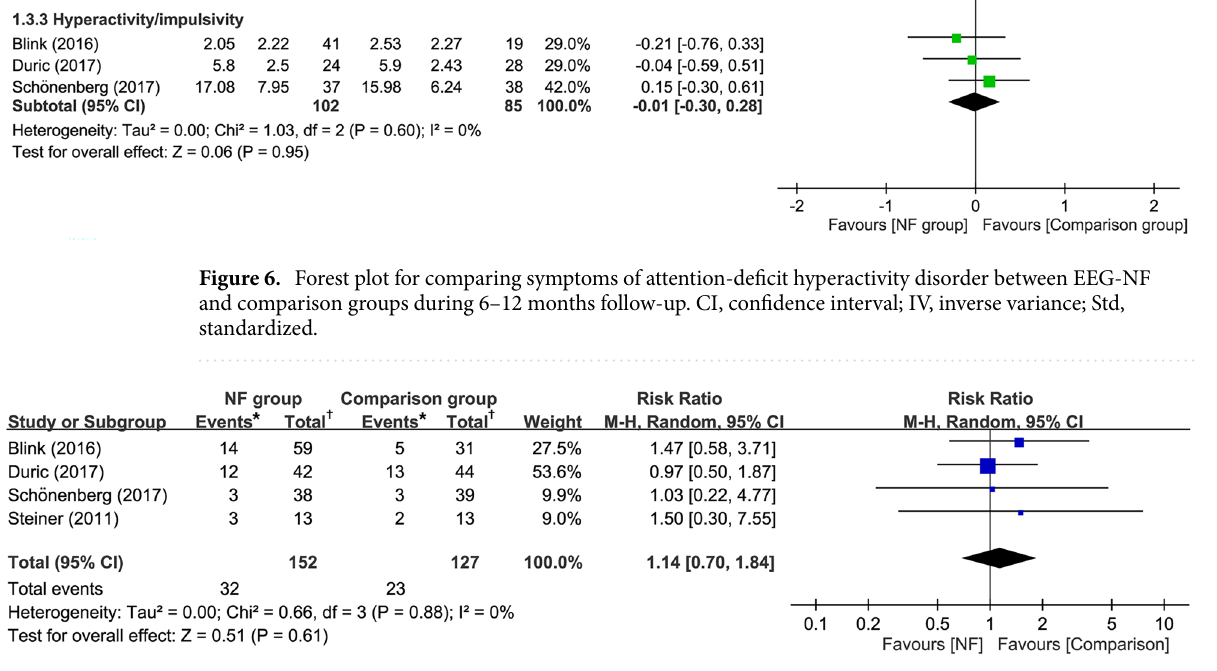
Figure 7. Forest plot for comparing dropout rate between EEG-NF and comparison groups. CI, confidence interval; M-H, Mantel–Haenszel. *Total number of participants in intervention groups or in comparison groups; †Number of dropout events in intervention groups or in comparison